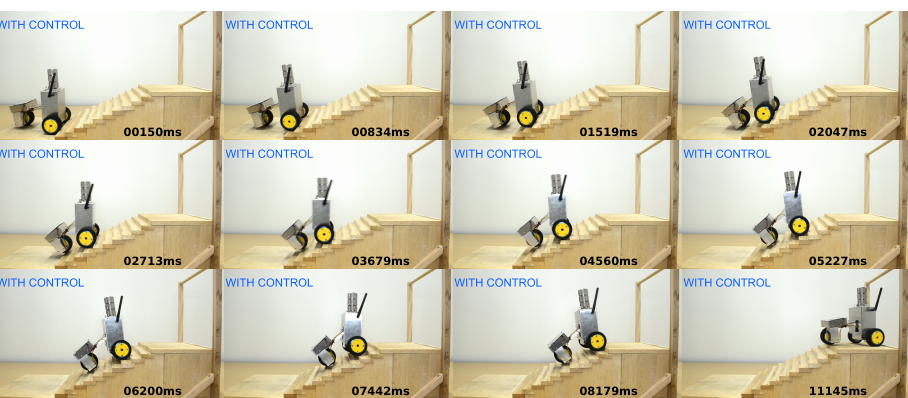
Figure 17. Prototype ascending with control (time stamps in milliseconds are roughly estimated from the videos).